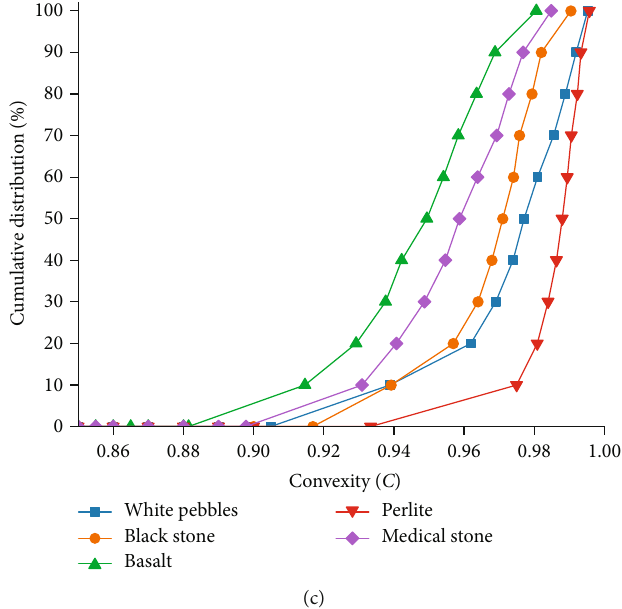
Figure 5: Cumulative distribution for (a) aspect ratio, (b) convexity, and (c)